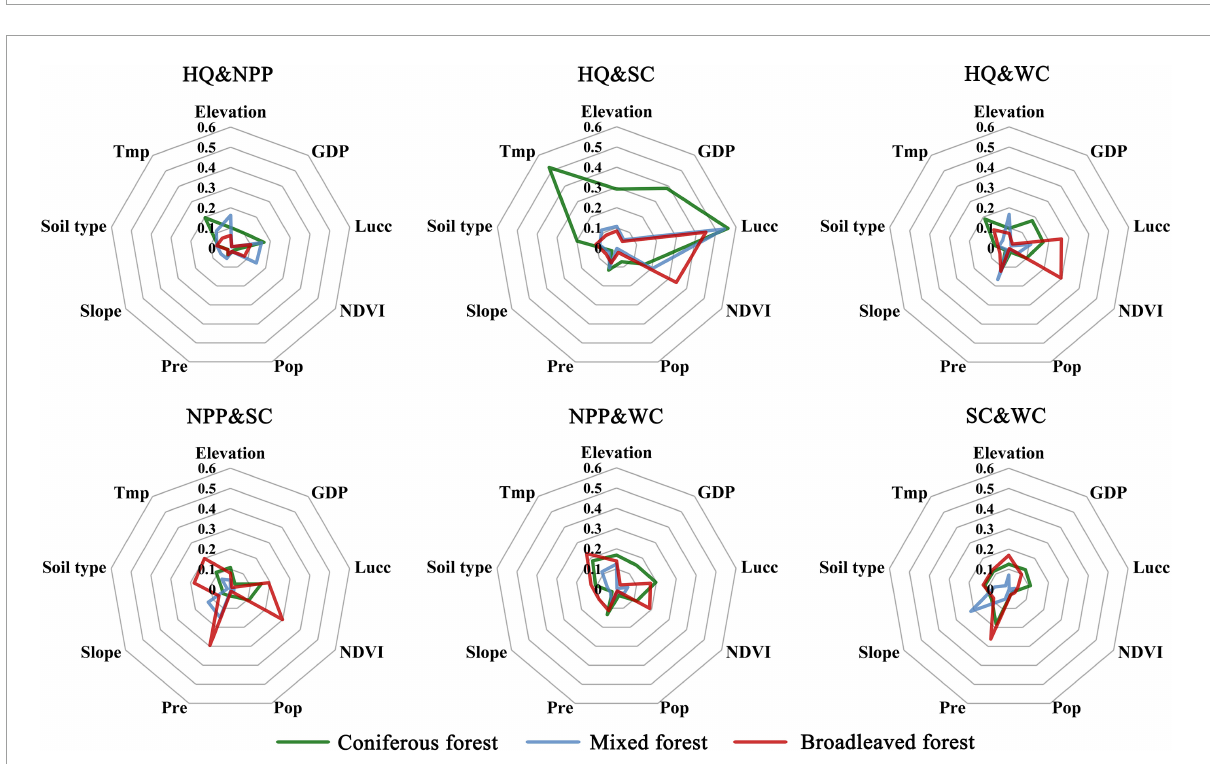
FIGURE6 Influence of drivers on forest ecosystem service trade-offs. GDP, Gross Domestic Product; Lucc, land use type; Pop, population density; Pre, precipitation, and Tmp, temperature.